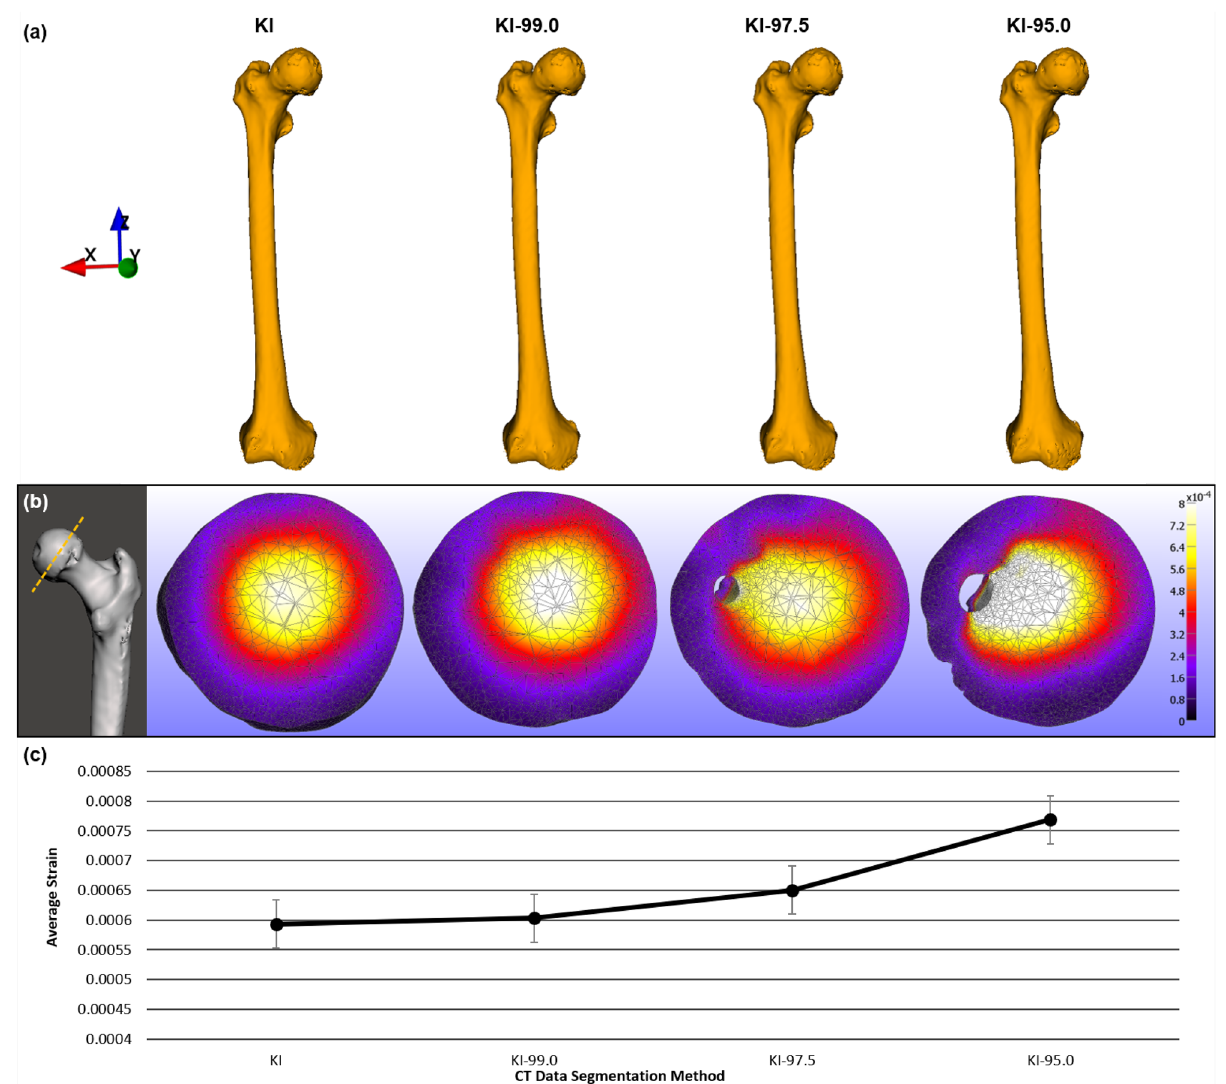
Figure 2. Visually comparable 3D anatomical models yield different biomechanical data. ( a ) 3D models of the same right femur specimen generated using 4 different segmentation methods (anterior view). ( b ) Cross- sections of femoral head revealing hidden internal morphological variations and heatmaps showing strain data variation. ( c ) Average strain data (n = 63) from finite element models generated with 4 segmentation methods. 3D mesh visualizations generated with MeshMixer 3.5.474, www. meshm ixer. com; data heatmaps generated with FEBio Studio 1.0.0, https:// febio.